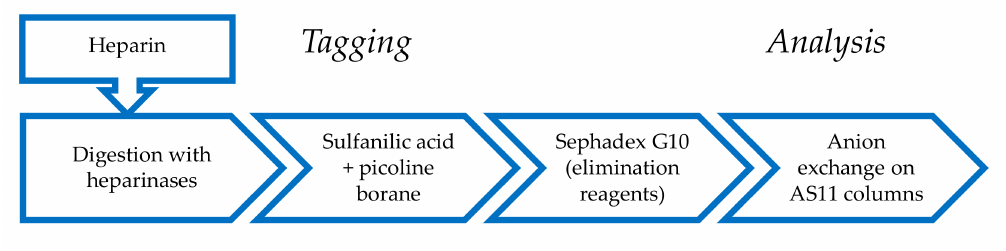
Figure 3. Building block analysis of a heparin sample using sulfanilic tagging.